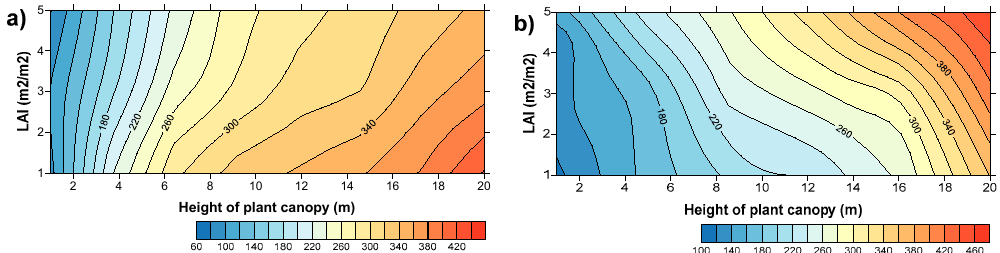
Figure 1. Dependence of the distance between the “point” of the air flow re-establishment and vegetation edge on the height and density of vegetation for the first ( a ) and second ( b ) scenario (for 30 m above the surface).